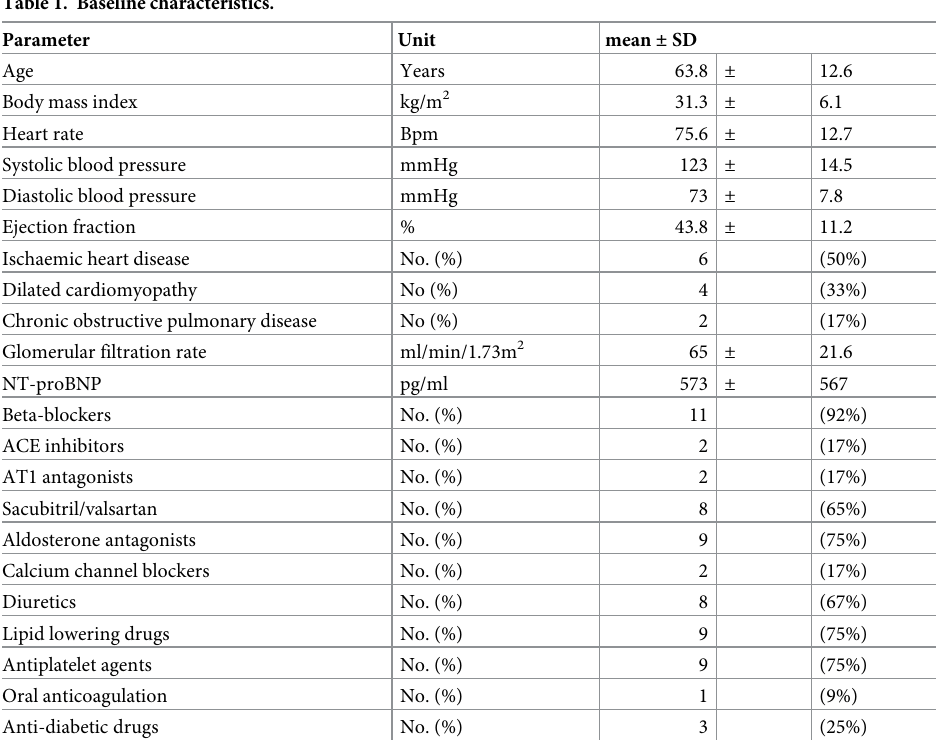
Table 1. Baseline